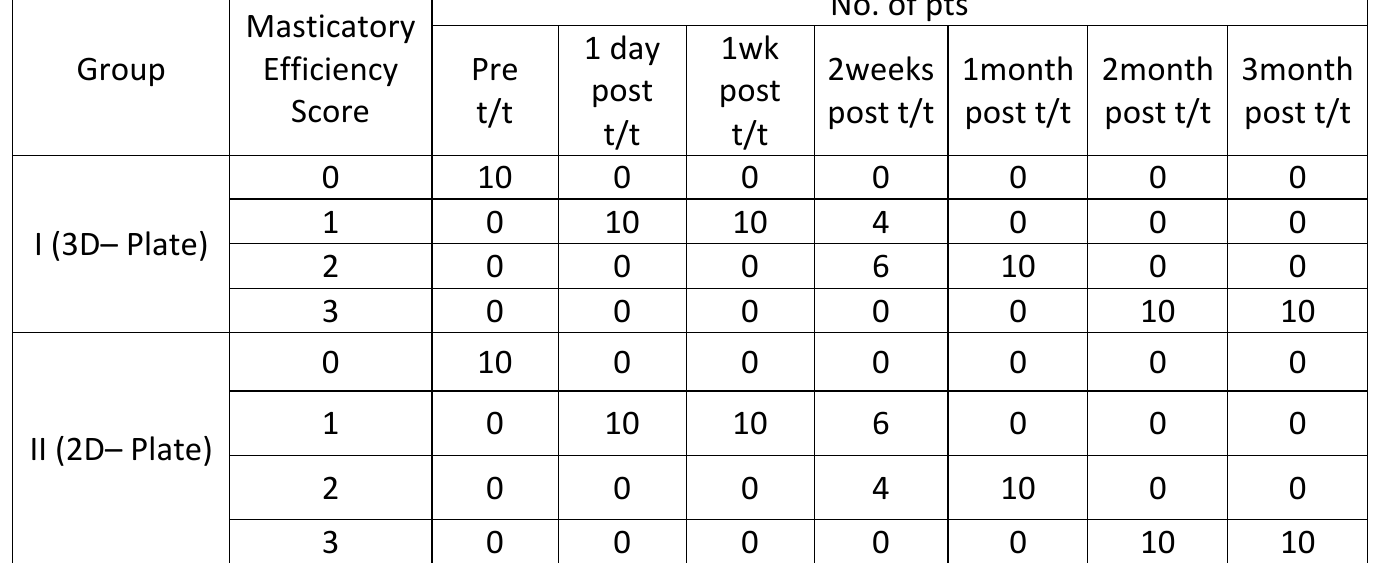
Table 5: Masticatory Efficiency